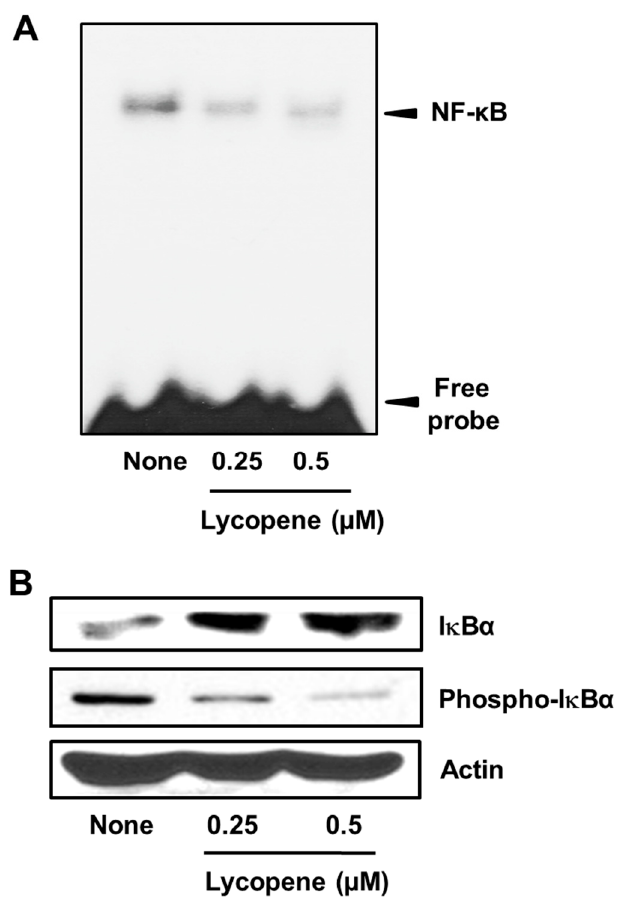
Figure 4. Lycopene reduced NF- κ B-DNA binding activity and phospho-I κ B α levels in PANC-1 cells. Cells were treated with the indicated concentrations of lycopene for 24 h. ( A ) DNA-binding activity of NF- κ B in nuclear extracts was examined by using electrophoretic mobility shift assay (EMSA). “None” corresponds to the untreated cells; “0.25” and “0.5” correspond to the cells treated with 0.25 and 0.5 µ M lycopene, respectively. ( B ) Western blot analysis was performed for the levels of phospho-I κ B α and I κ B α (and the protein standard actin). Designations of the columns are the same as in ( A ).